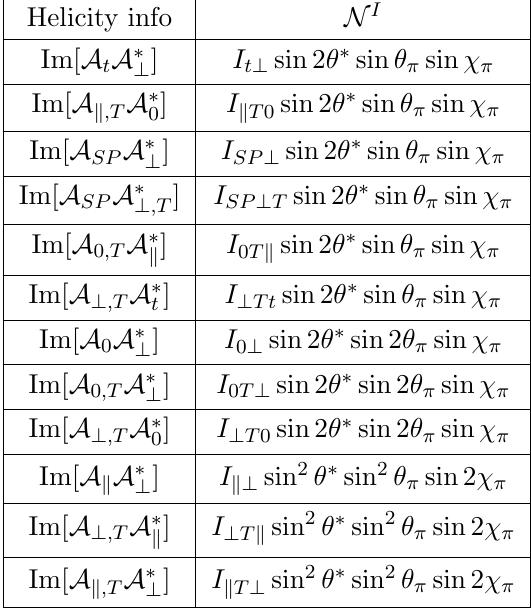
Im[ A i A (cid:3) ] pieces of eq. (2.15). The coe(cid:14)cients I i depend on the i;j j